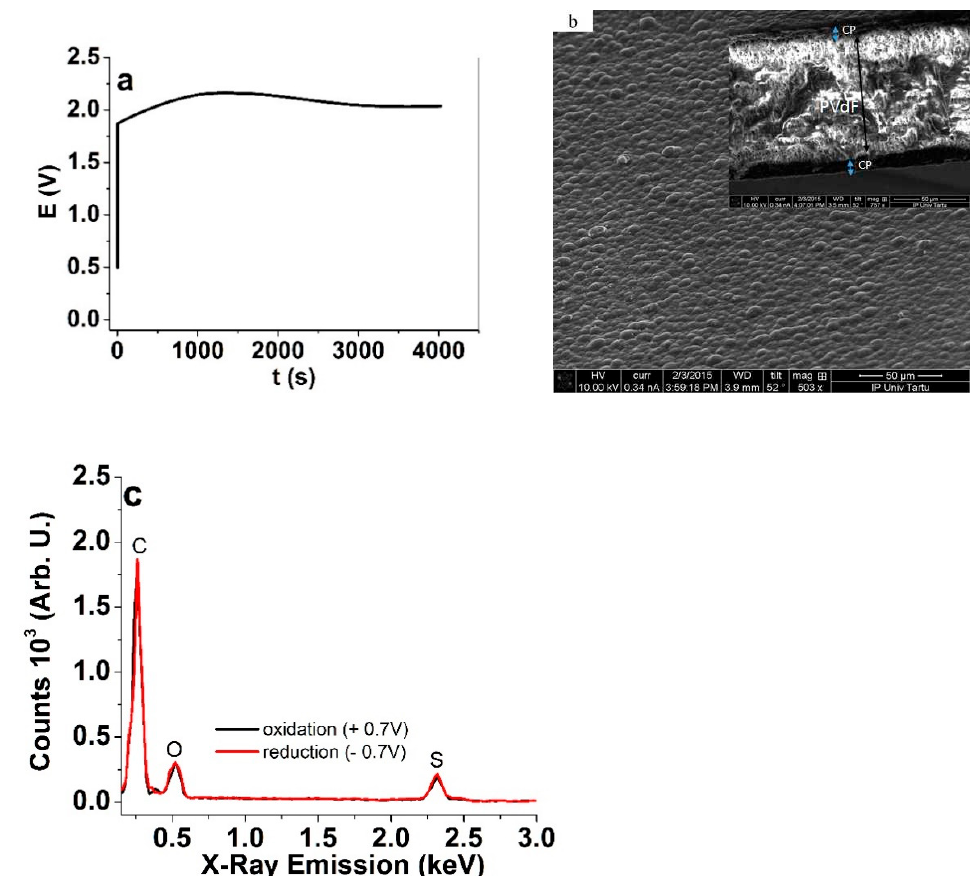
Figure 2. ( a ) The galvanostatic polymerization curve (two-electrode cell) of polypyrrole (PPy) on a chemically PPy-coated polyvinylidene fluoride (PVdF) membrane at − 5 °C, (0.1 mA cm − 2 , 4000 s); ( b ) SEM micrographs (scale bar 50 µ m) of the surface of an M1 actuator with the cross section in the inset showing arrows of PVdF and the deposited conducting polymer. ( c ) EDX surface spectra of M1 after actuation, oxidized at +0.7 V (black curve) and reduced at − 0.7 V (red curve).